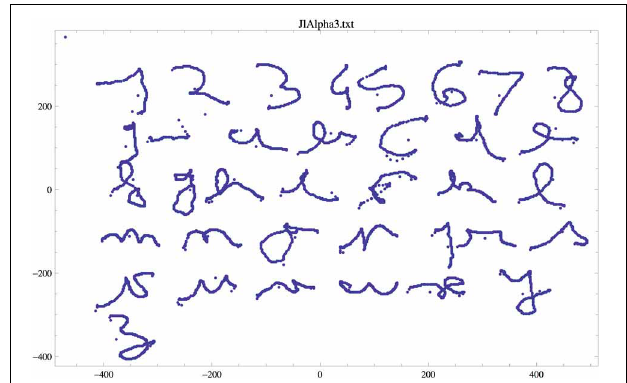
FIGURE 1 | Example of letters and digits written with his eyes by author JL (note that a spurious character, between the “9” and “a,” appears in this example, and was manually removed before further